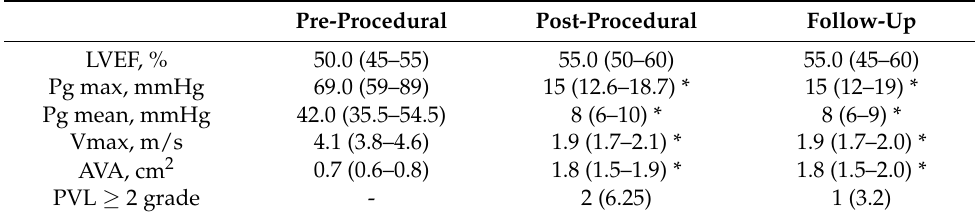
Table 2. Echocardiographic